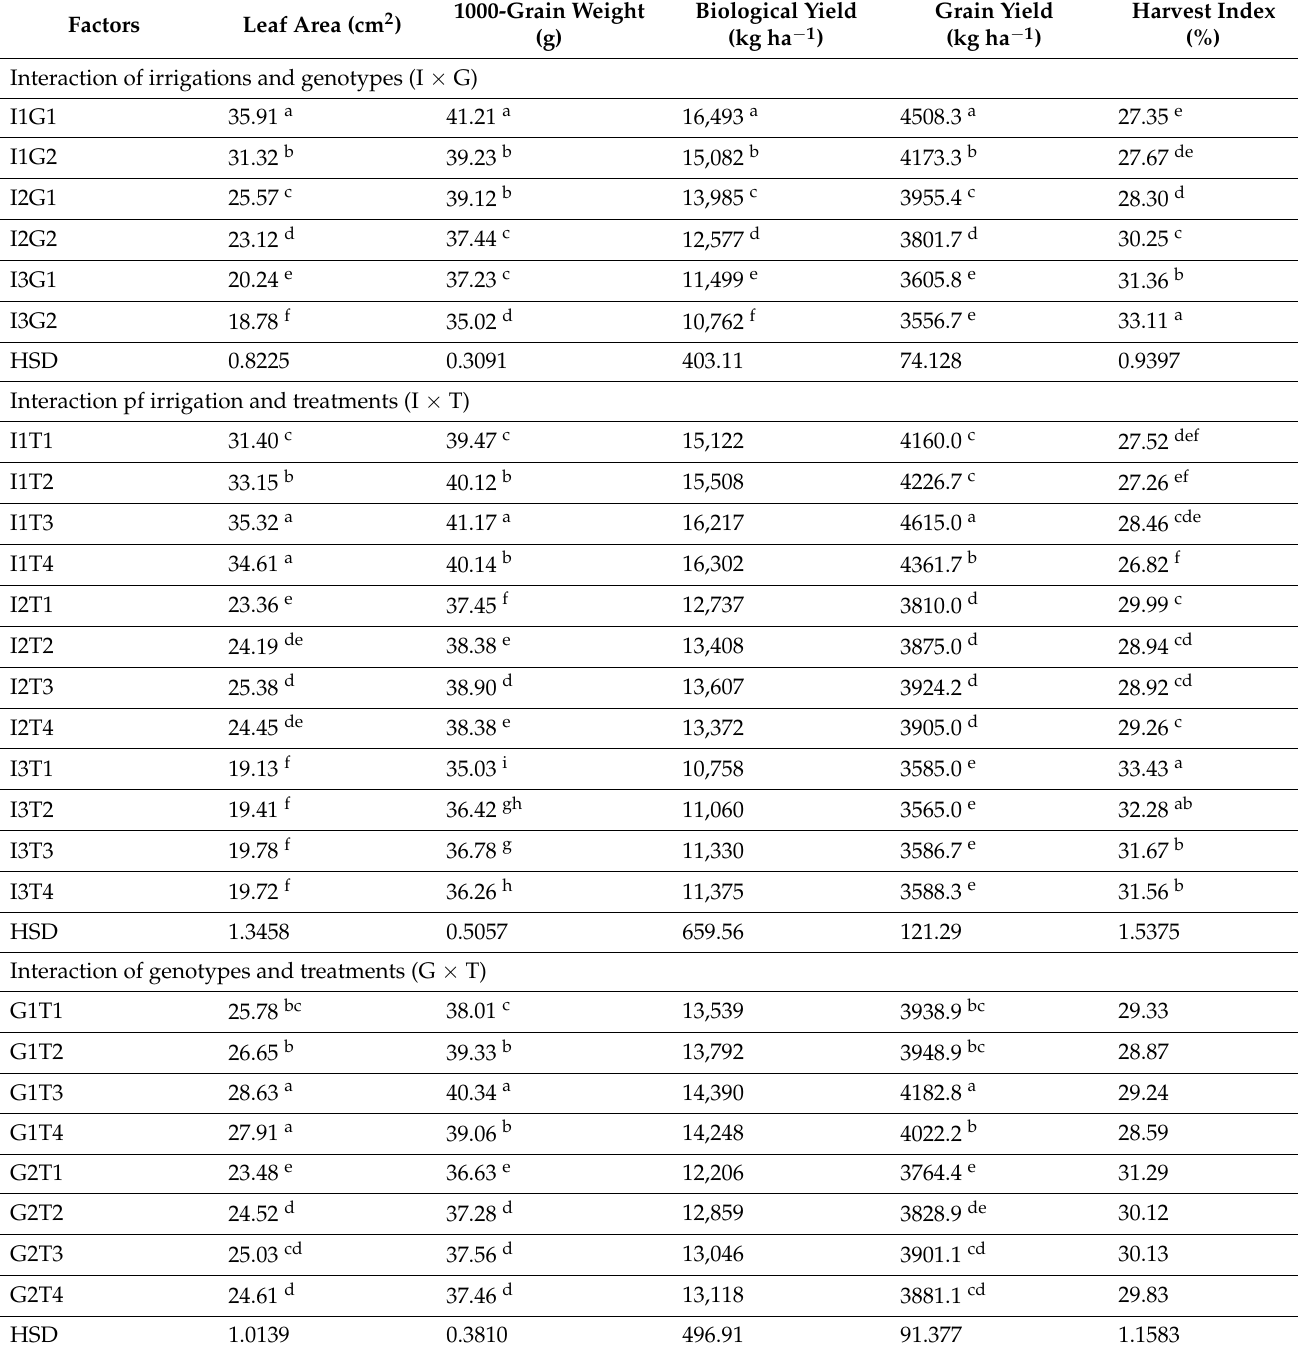
Table 8. Interactive response of two factors regarding leaf area, 1000-grain weight, biological yield, grain yield and harvest index of triticale